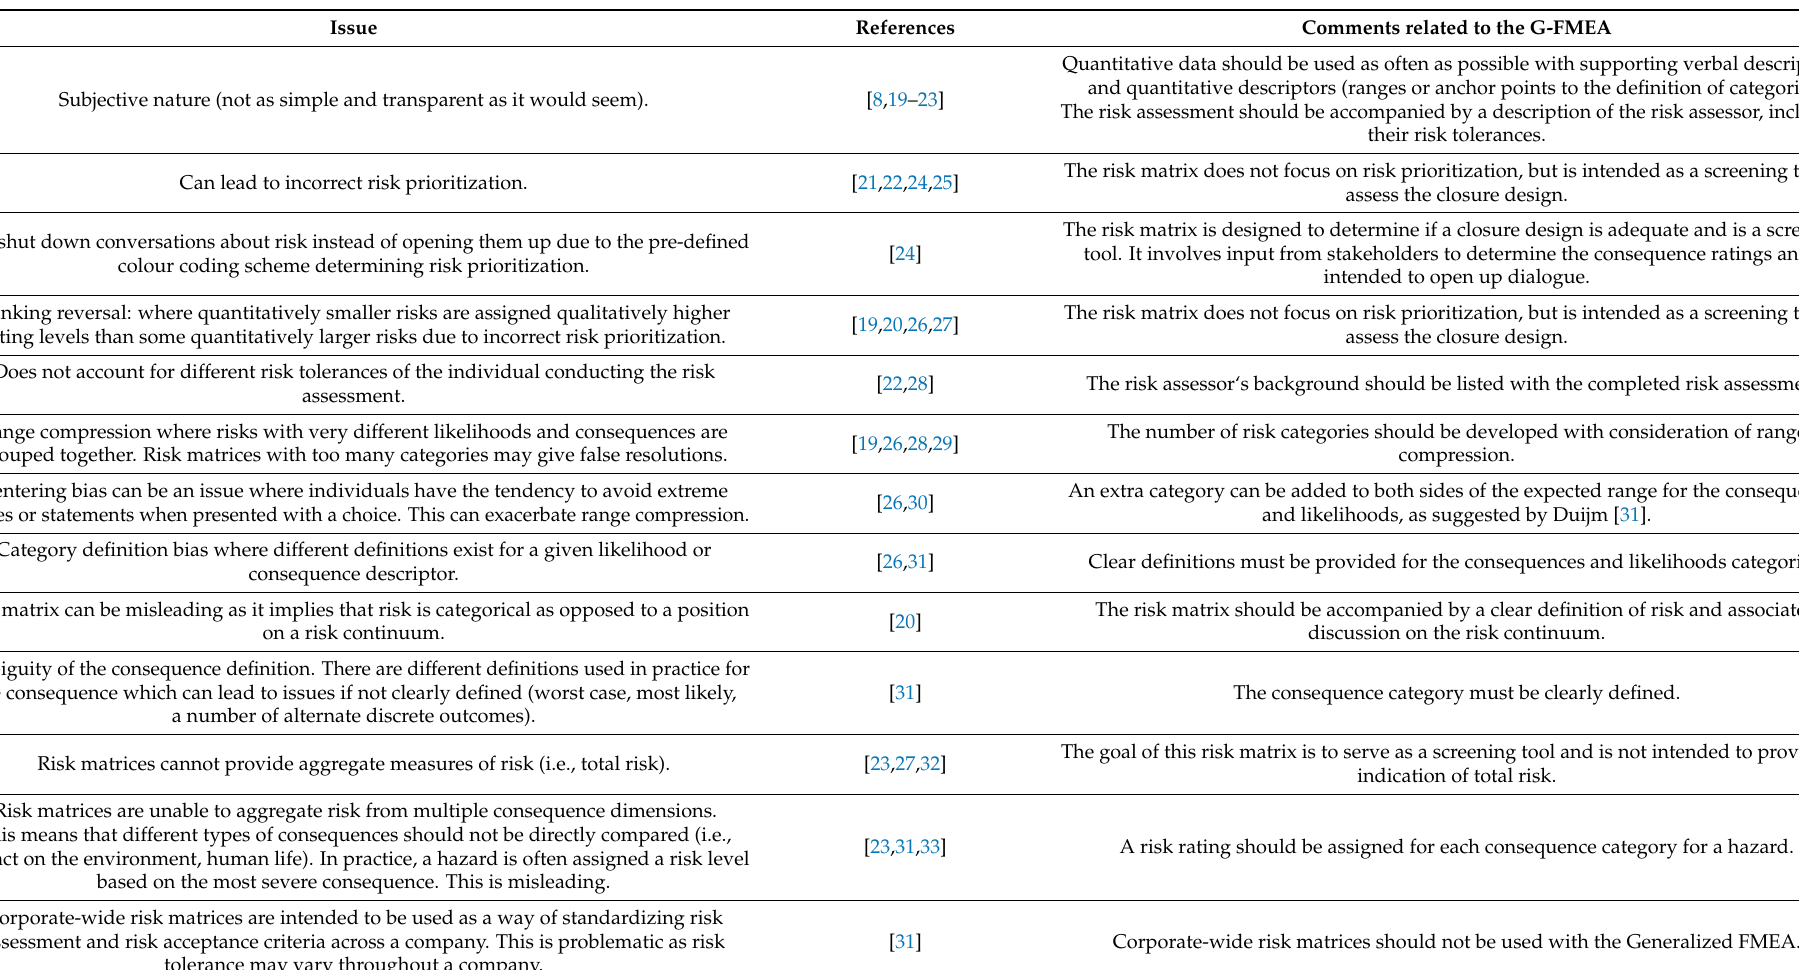
Table 1. Risk matrix issues, references, and associated comments related to the